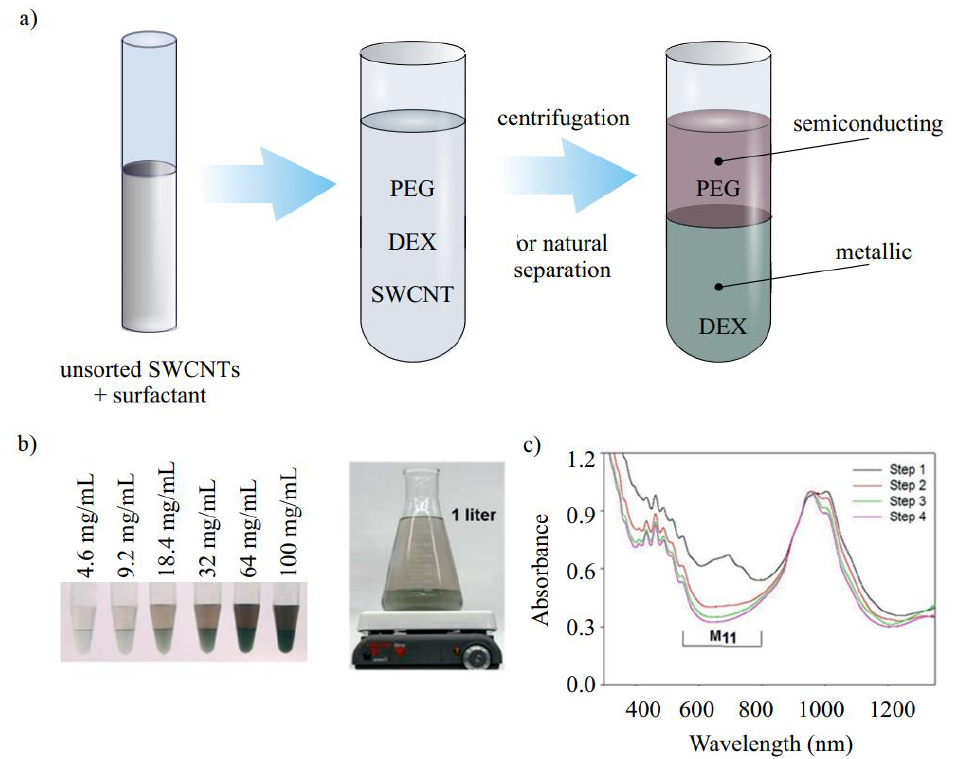
Figure 16. ( a ) Schematic image of two-phase extraction. The PEG, DEX, SWCNTs with cosurfactants are mixed. After the centrifugation or several hours of natural separation, the distinct layers at the top and bottom phases were observed. ( b ) The scalable and highly reproducible sorting of SWCNT by electronic type. The amount of CNT loading (from 4.6 to 100 mg/mL) is written. A 1 L volume partition sample. ( c ) Absorption spectra of semiconducting CNT fractions obtained from four steps of repeated partition [105]. Copyright 2013, American Chemical Society.